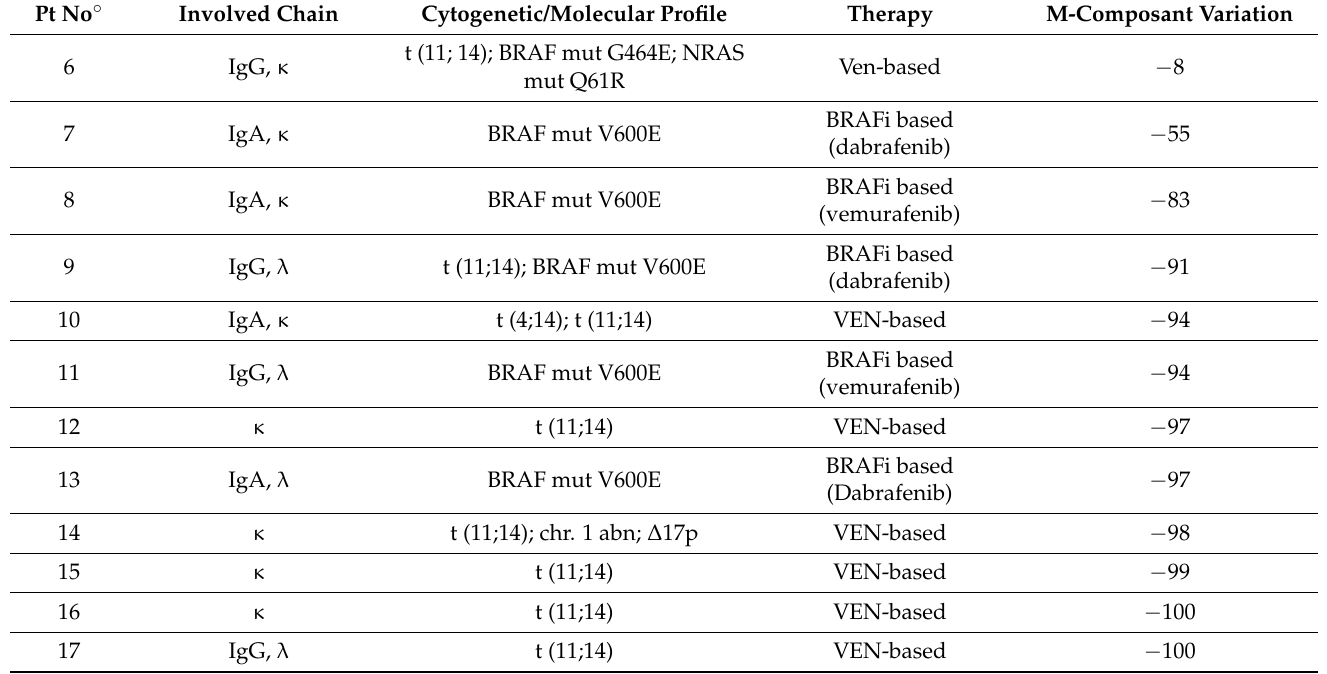
Table 2. Outcome data in the whole population and subgroups. MO: molecularly oriented. All Patients ( n = 103)